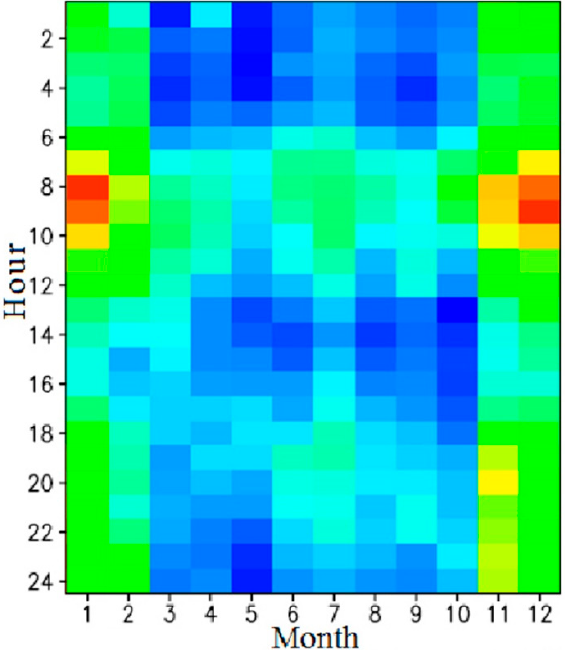
Figure 5. Hourly–monthly means of nitrogen oxide (NO x ) concentration at an observation point near the Koto site for 2010.